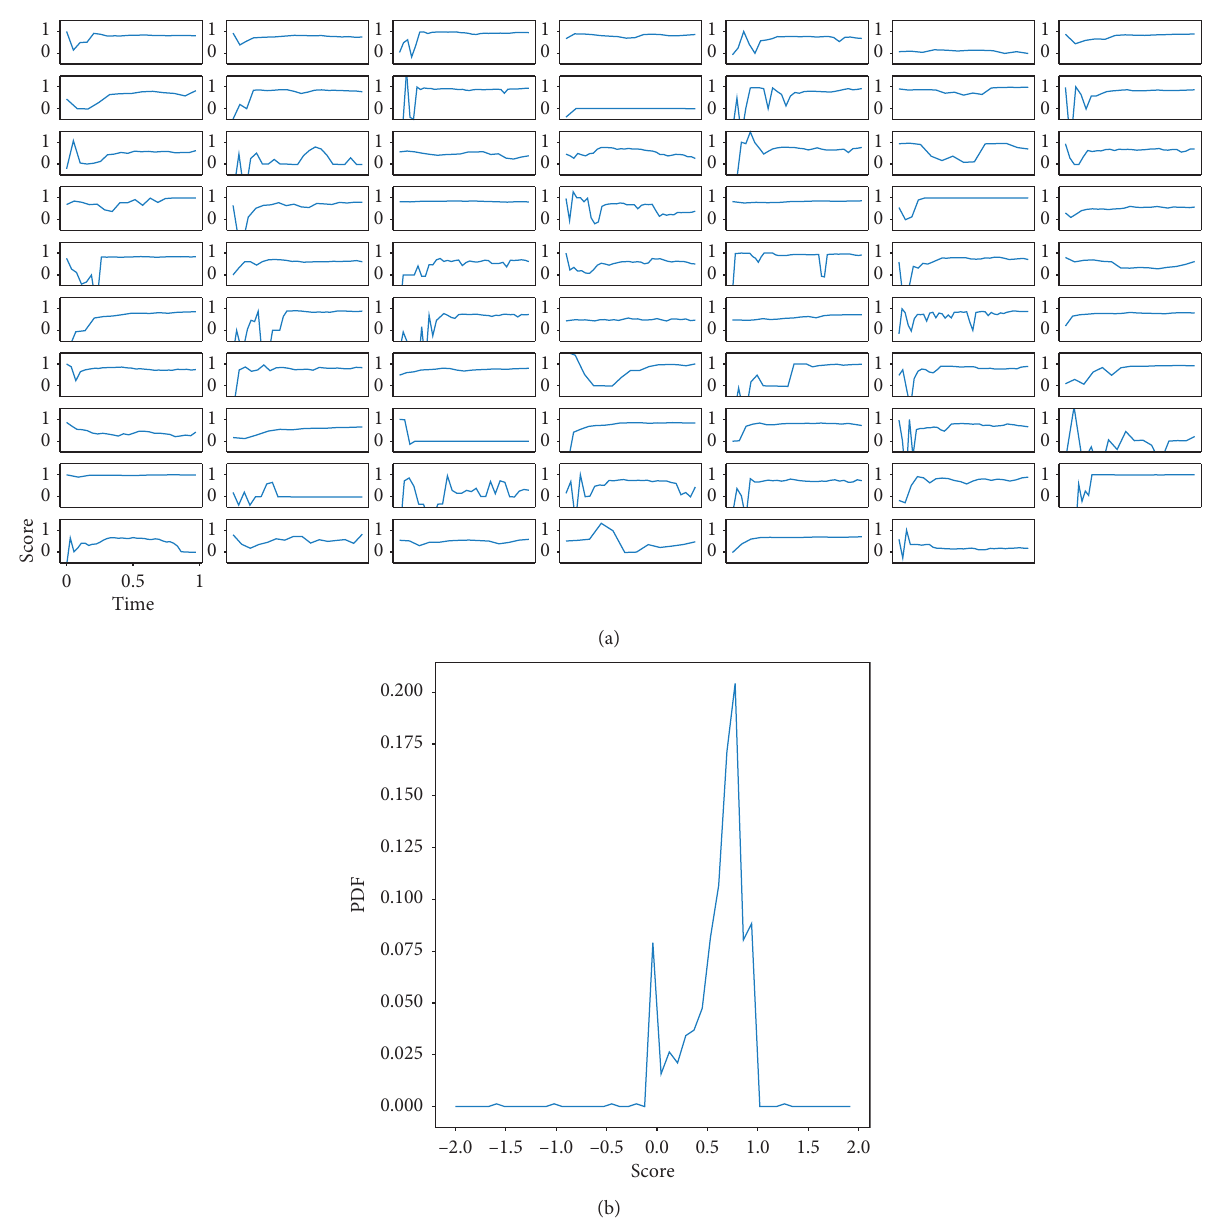
Figure 11: Efficacy score for selected enterprises. (a) Efficacy score time series of enterprises with at least one year of activity. (b) Distribution of the monthly efficacy score over the last year of